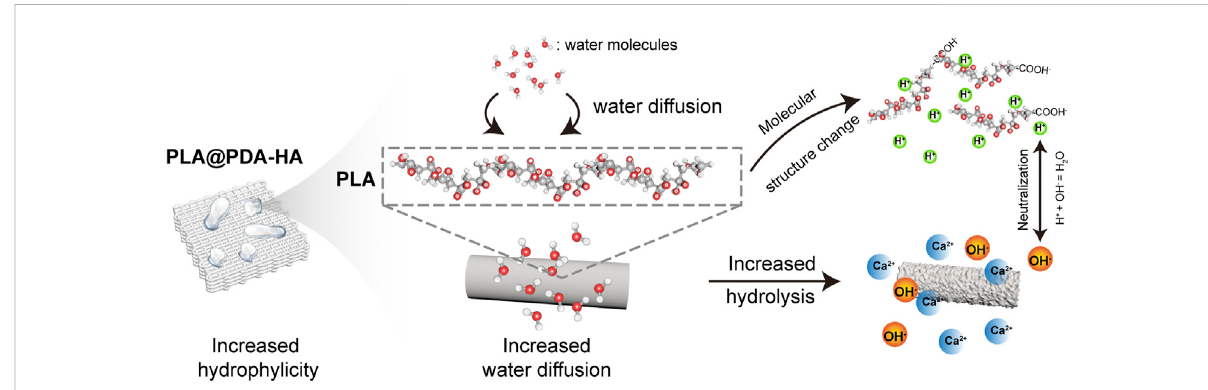
FIGURE 9 Schematic illustration of hydrolysis process of PLA@PDA-HA scaffolds. The increased surface wettability of nHA-modi fi ed PLA scaffolds enhances waterdiffusion,bywhichPLAchains are “ attacked ” byamore signi fi cantnumberofwatermolecules. Asaresult, anacceleratedhydrolysis process, namely the cleavage of the ester bond, took place, and in turn, a local acidic environment was formed due to the exposure of the carboxyl group. The hydroxyl group from nHA and PDA neutralized the local acids